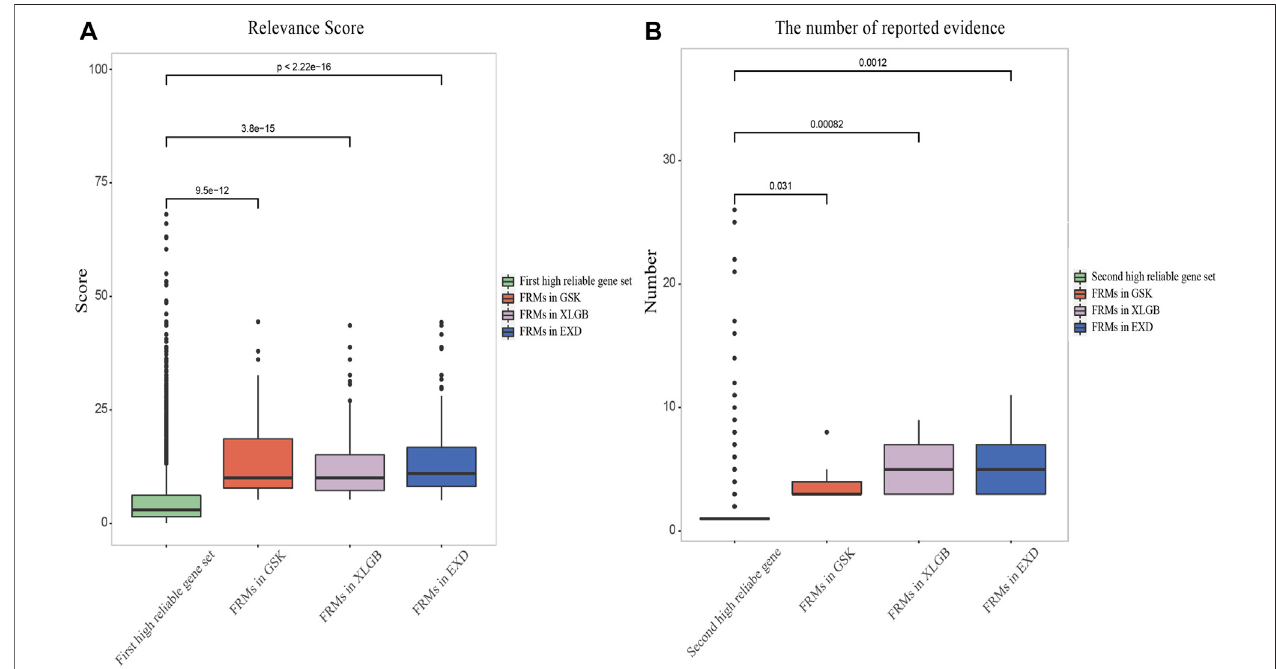
FIGURE 6 | Validation of FRMs. Relevance score (A) and the number of reported evidence (B) of FRMs and two high reliable pathogenic gene sets of OP were compared.